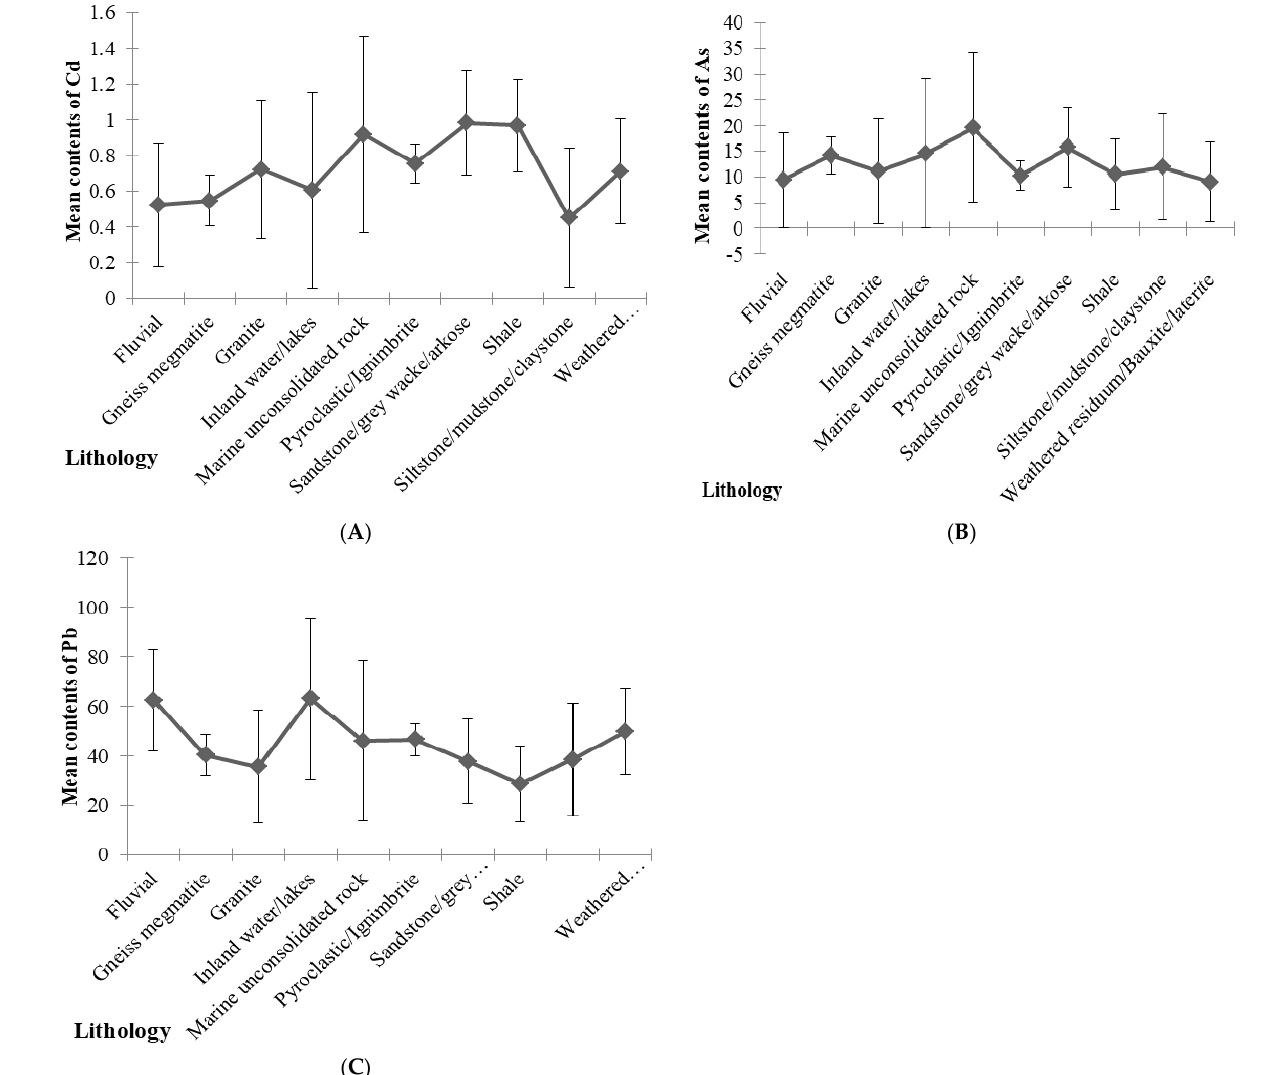
Figure 7. The effect of lithology on ( A ) Cd, ( B ) As, and ( C ) Pb